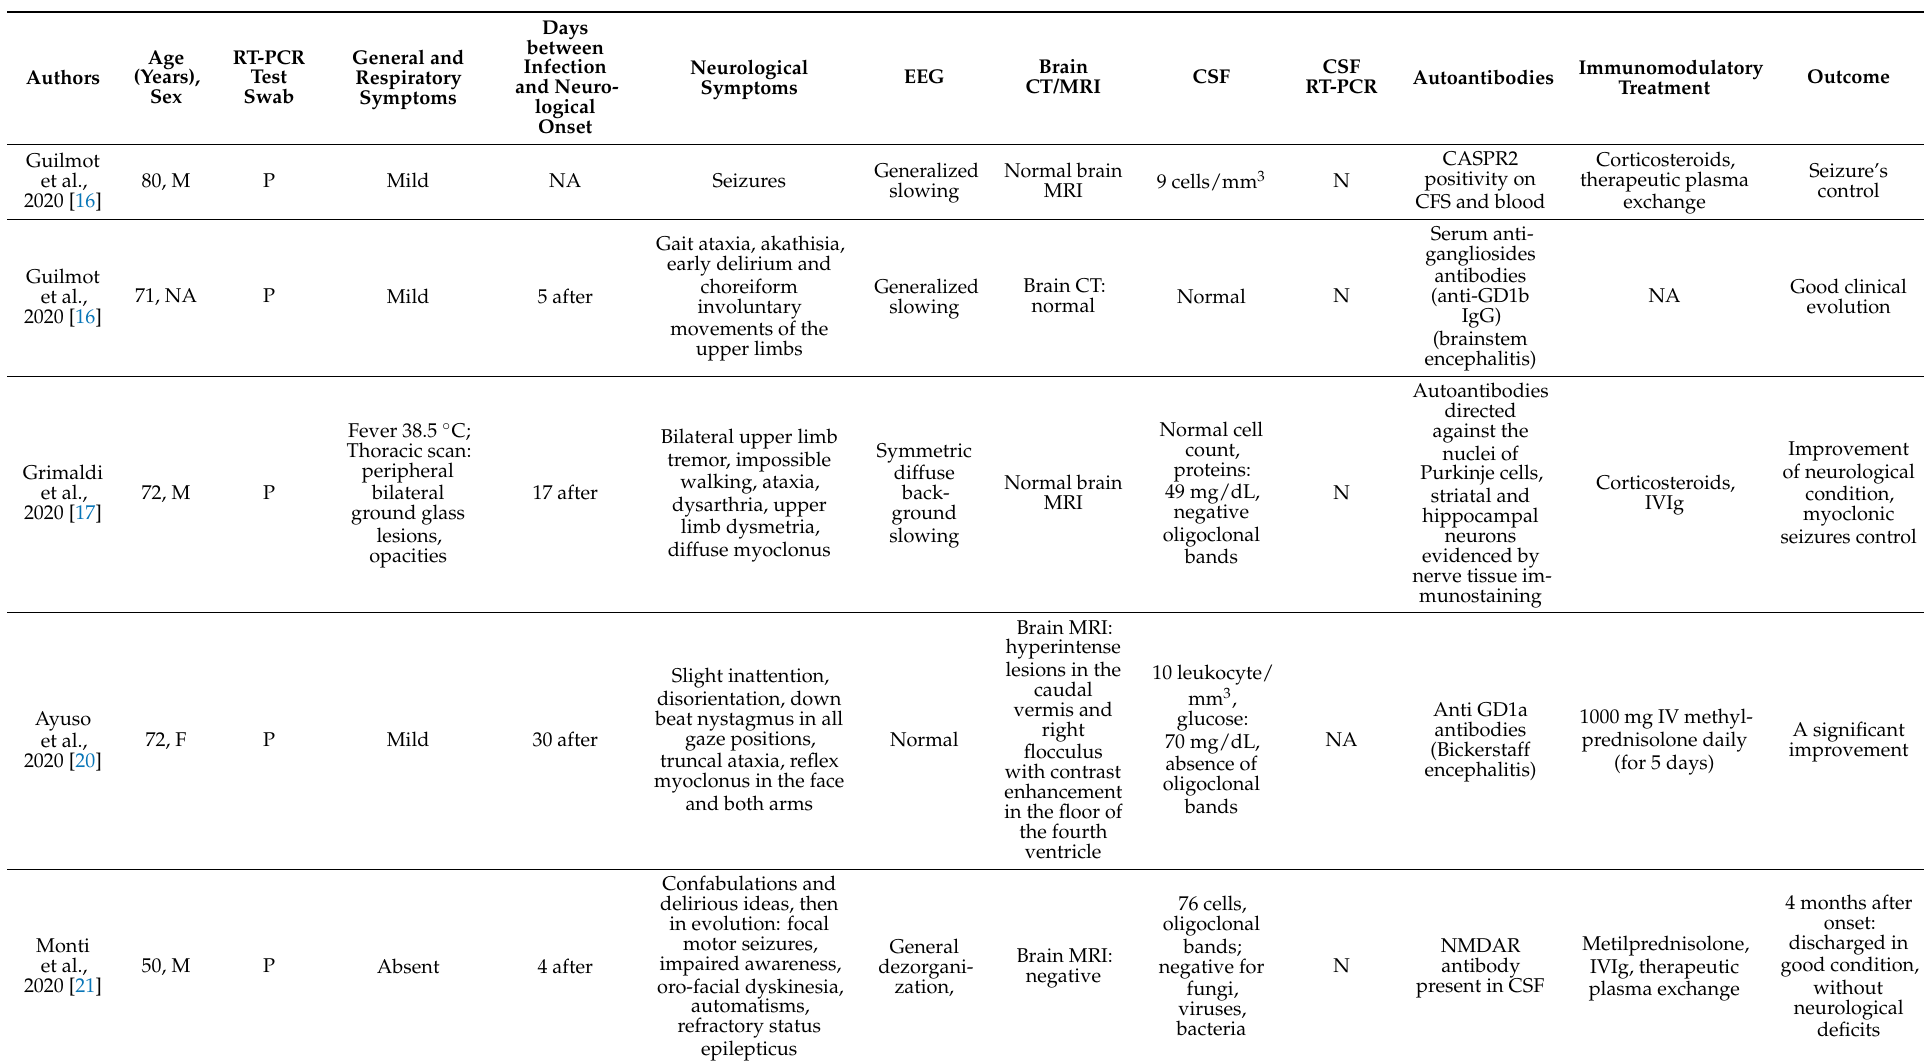
Table 1. Summary of the cases published in the